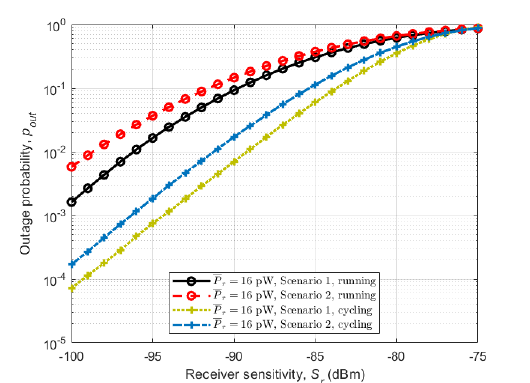
Figure 15. Outage probabilities p out in relation to the receiver sensitivity S r for all scenarios during running and cycling with average received power P r = 16